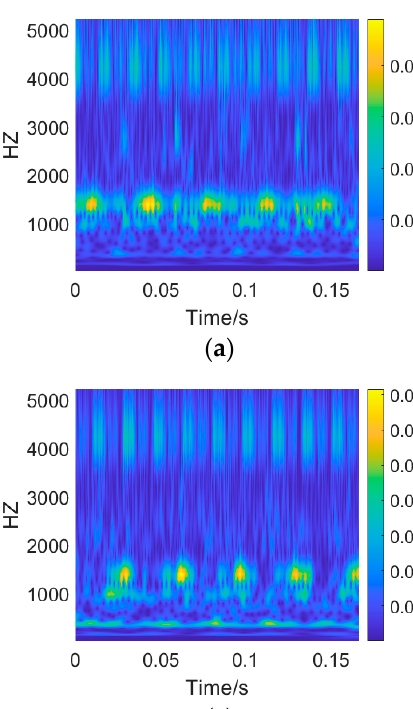
Figure 8. Fault feature visualization.